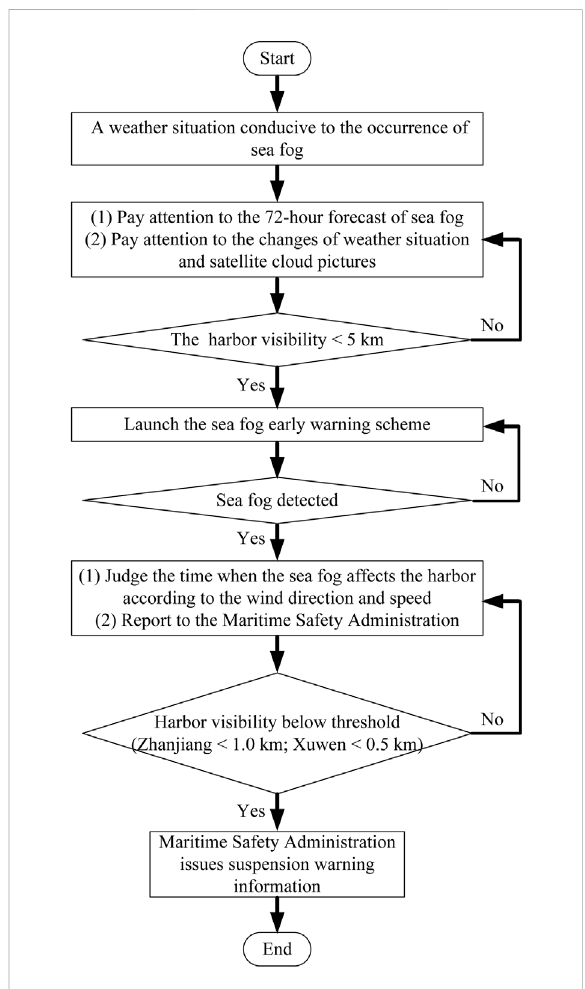
FIGURE 9 Flow chart of the early warning and monitoring